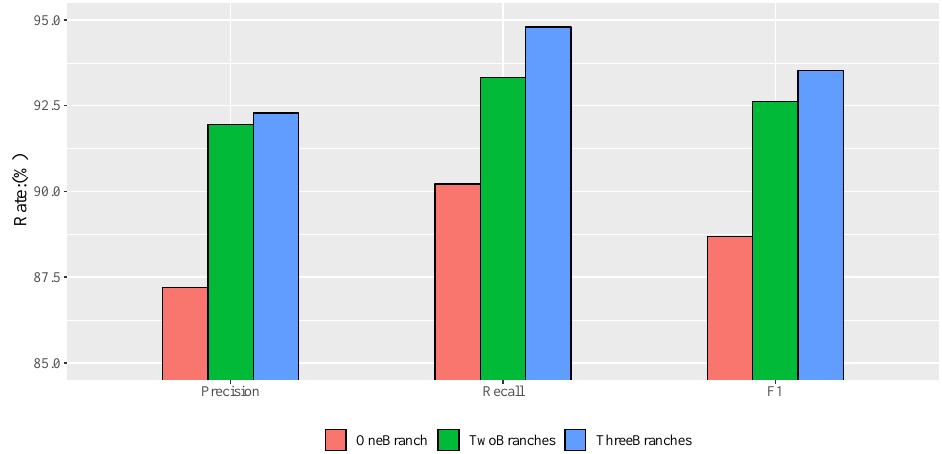
Figure 20. Comparison of detection results for different numbers of branch in Test Area 2.